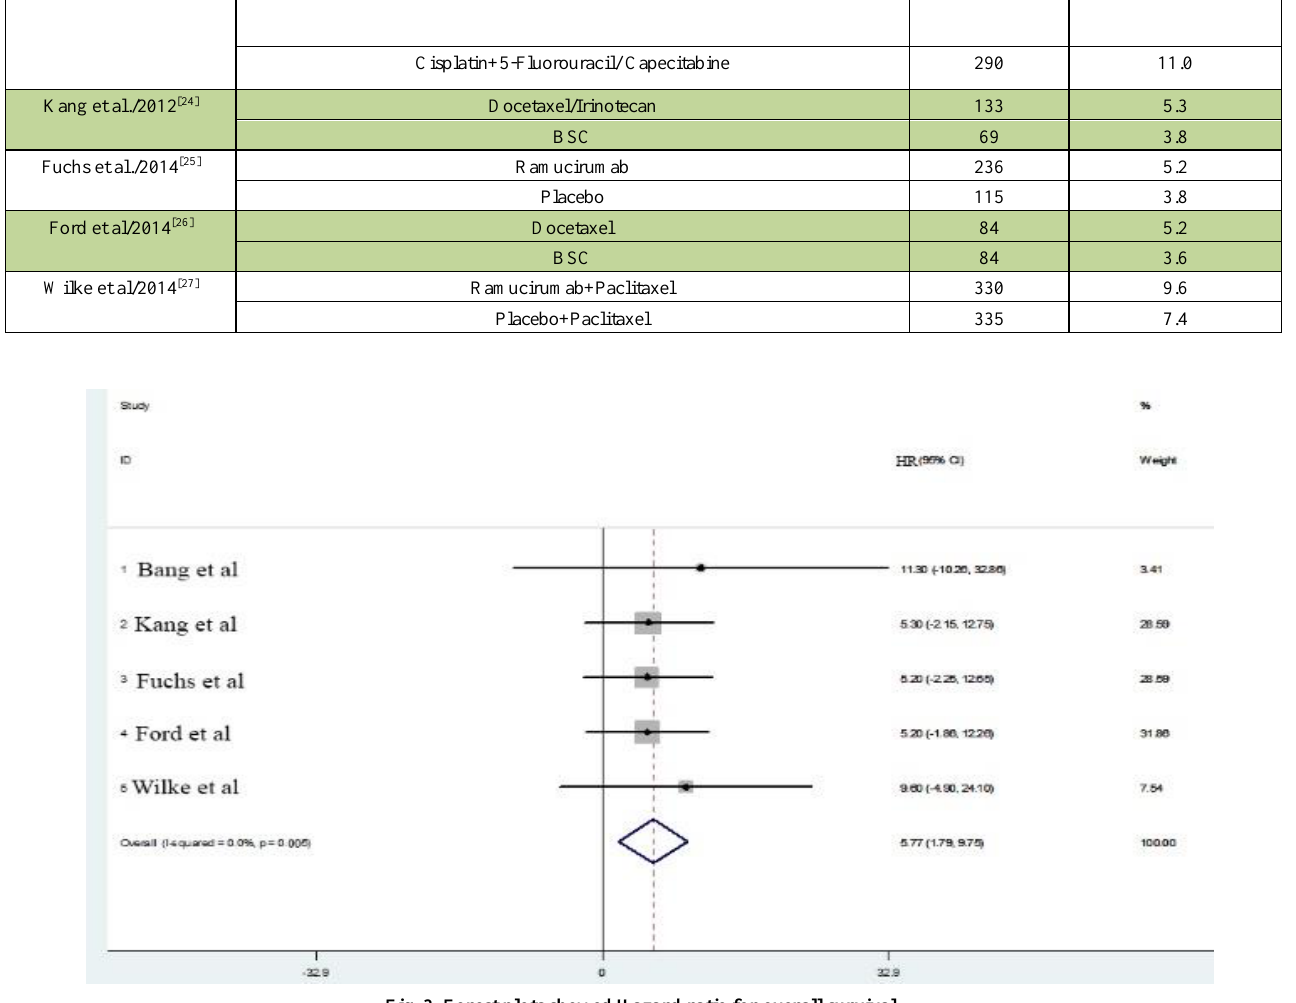
Fig. 3. Forest plots showed Hazard ratio for overall survival. Table 3. Studies selected for systematic review and meta-analysis for